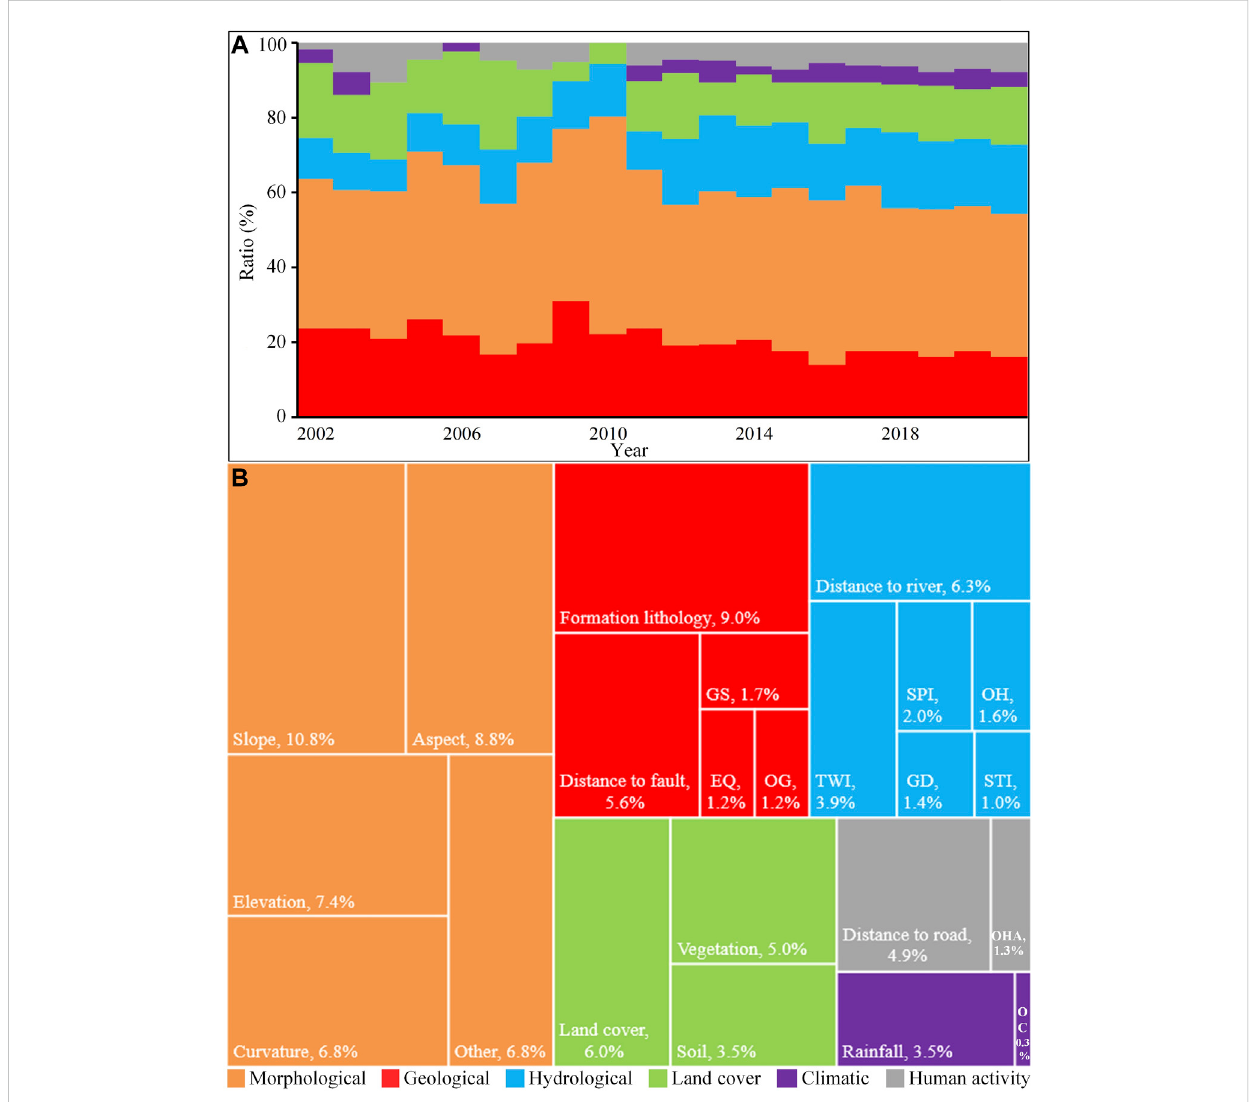
FIGURE 3 Utilization of environmental variables. (A) Proportion of different environmental variables in different years. (B) Application of different types (main categories and subcategories) of environmental variables. GS, Geological structure; EQ, Earthquake; OG, Other geological; TWI, Topographic wetness index; SPI, Stream power index; GD, Gully density; STI, Sediment transport index; OH, Other Hydrological; OHA, Other human activity; OC, Other